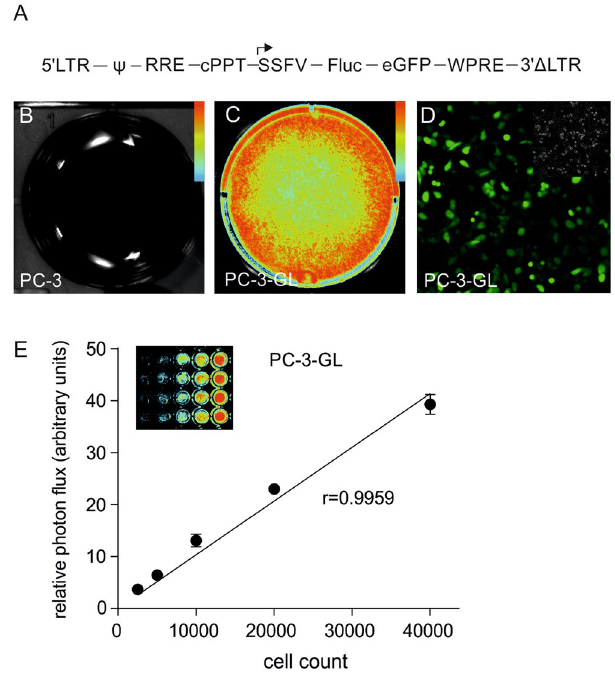
Figure 1. Validation of the reporter gene modified PC-3-GL cell line. ( A ) Schematic presentation of the bicistronic lentiviral vector. ( B ) In vitro BLI of PC-3 control cells. ( C ) In vitro BLI of PC-3-GL cells. ( D ) Fluorescence microscopy on PC-3-GL cells. The insert shows the corresponding brightfield image. ( E ) Correlation of bioluminescent light production and PC3-GL cell number. All color bar inserts range from 0 (blue) to 16383 (red) units photon flux. Abbreviations: Ψ , psi packaging sequence; RRE, rev response element; cPPT, central polypurine tract element; SSFV, spleen focus-forming virus promoter; eGFP, enhanced green fluorescent protein; Fluc, firefly luciferase; WPRE, woodchuck hepatitis virus post‐transcriptional regulatory